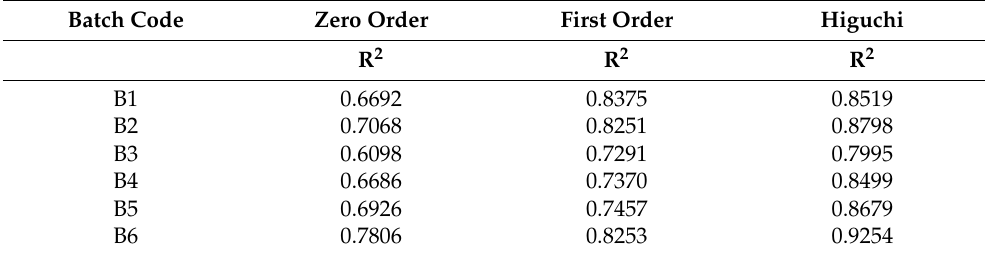
Table 4. In vitro release kinetics study.